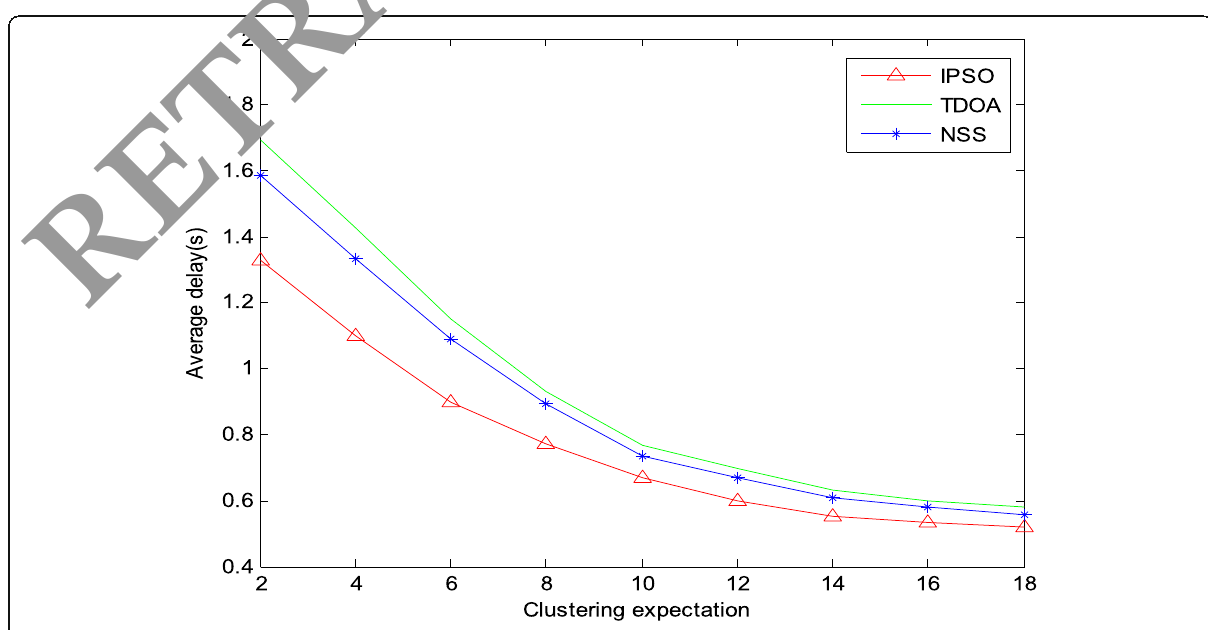
Fig. 6 Comparison of average delay of three